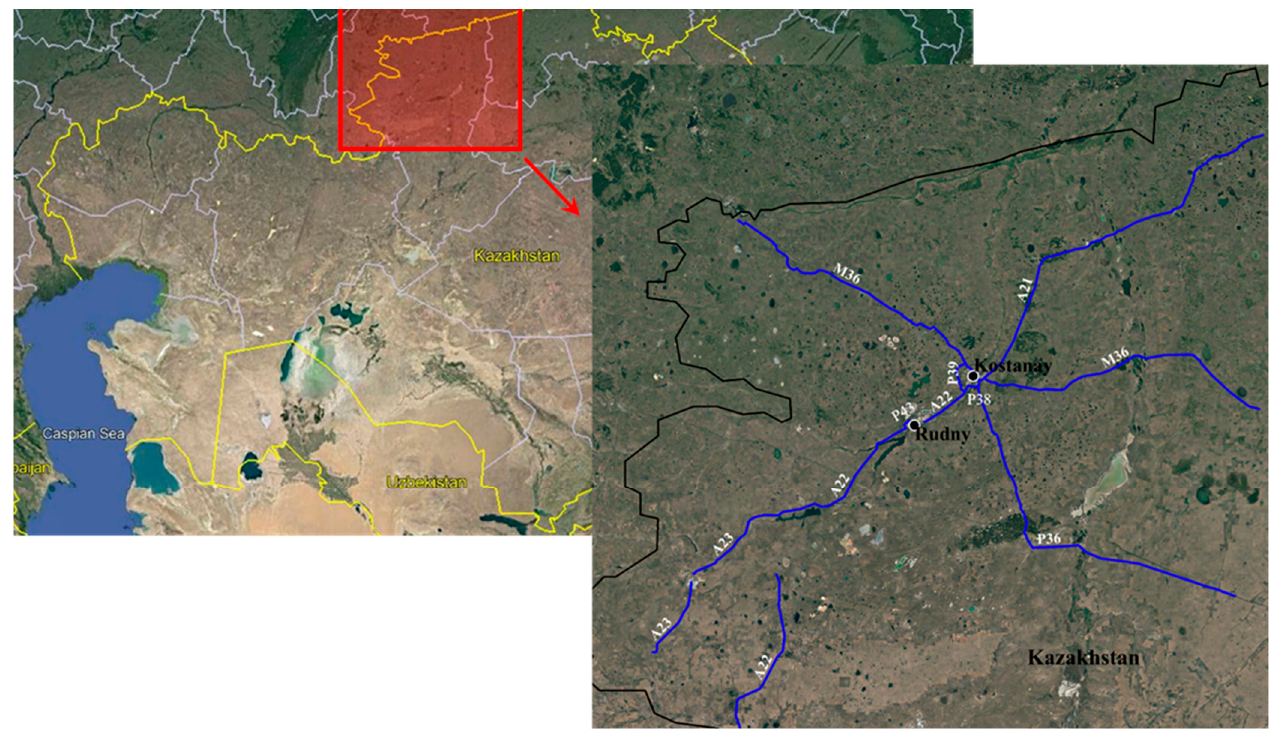
Figure 10. Examined roads—2468 km. Table 2. Road surface defects considered in the development of the model proposed in this study.